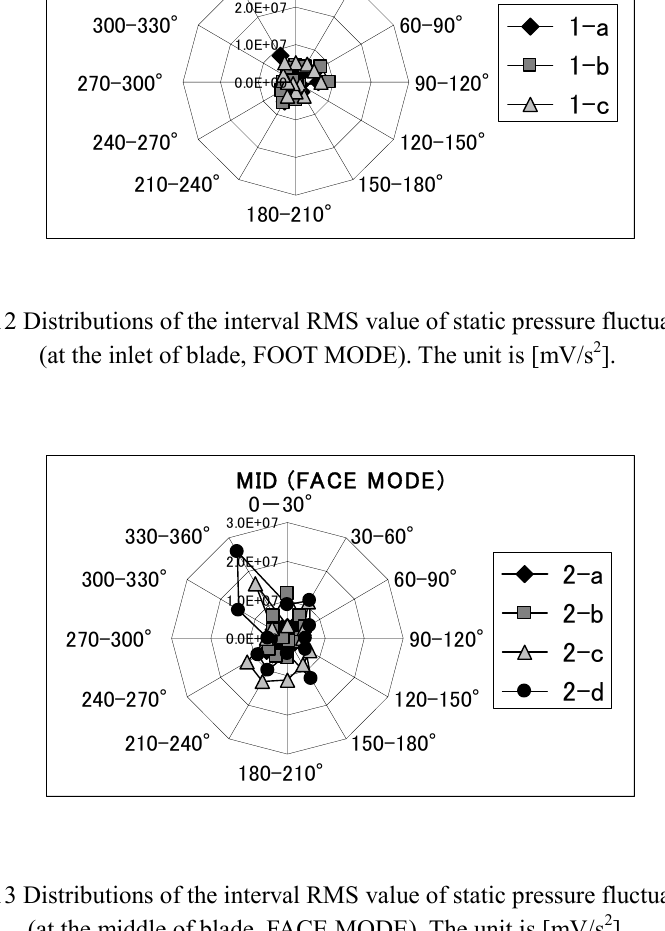
Fig. 13 Distributions of the interval RMS value of static pressure fluctuation (at the middle of blade, FACE MODE). The unit is [mV/s 2